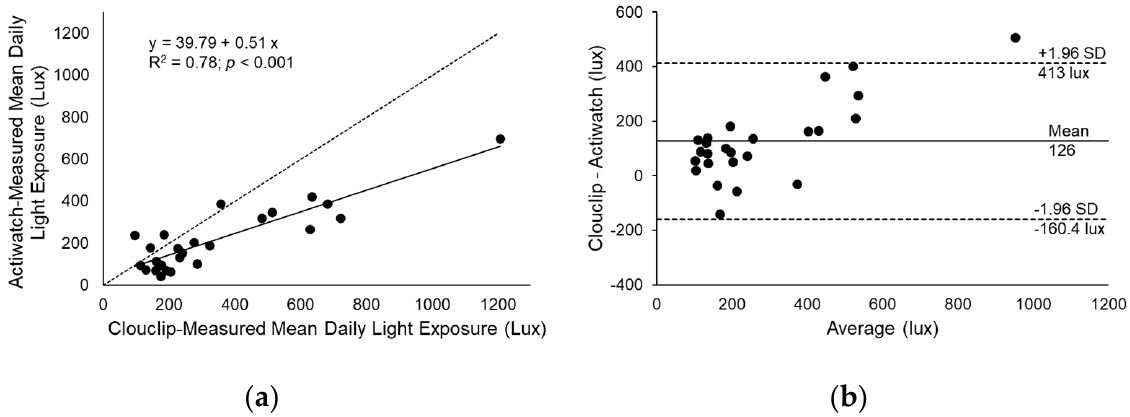
Figure 3. ( a ) Linear regression (solid line) between mean daily light exposure measured with Clouclip and Actiwatch; dashed line represents 1:1 line, and ( b ) Bland–Altman analysis of mean daily light exposure measured with the Clouclip and Actiwatch; solid line represents the mean difference and dashed lines represent the limits of